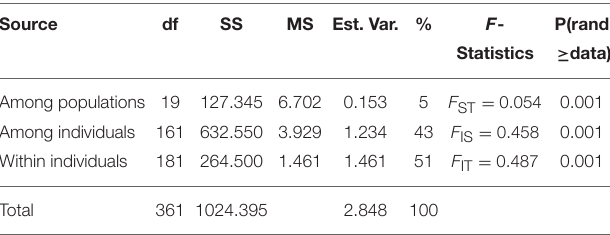
TABLE 3 | Partition of the molecular variance (AMOVA) among and within pine seedling groups.